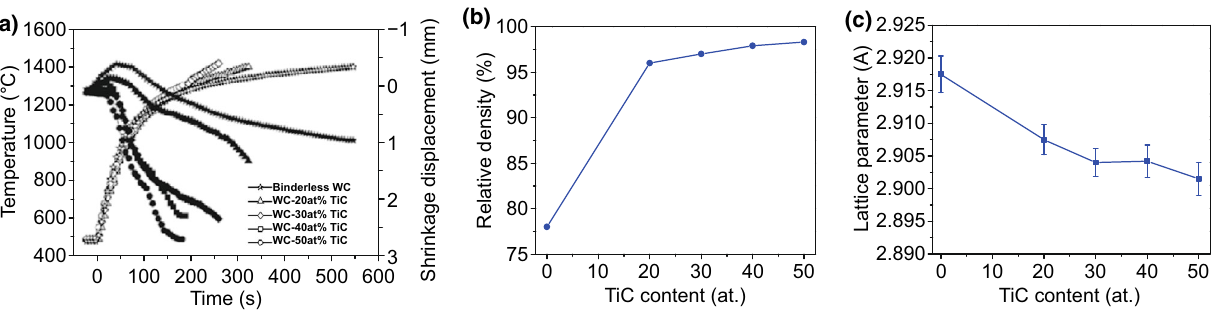
Fig. 4 a Variations of temperature and shrinkage displacement with heating time during high‑frequency induction heated sintering of WC– x at.% TiC hard materials (under 60 MPa pressure, 2800A). b Relative density as a function of TiC content. c Plot of WC phase lattice parameter as a function of TiC content produced by PCAS [79]. Figure panels reproduced from Ref. [79] with permission from Hanyang Univer‑ sity copyright